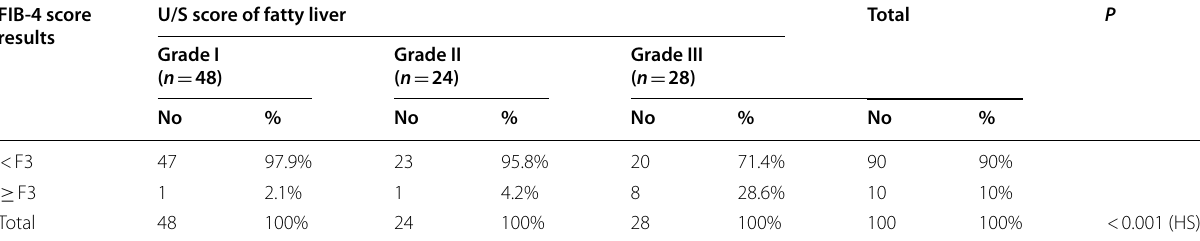
Table 9 Relation between U/S grade of fatty liver and FIB-4 score results FIB-4 score